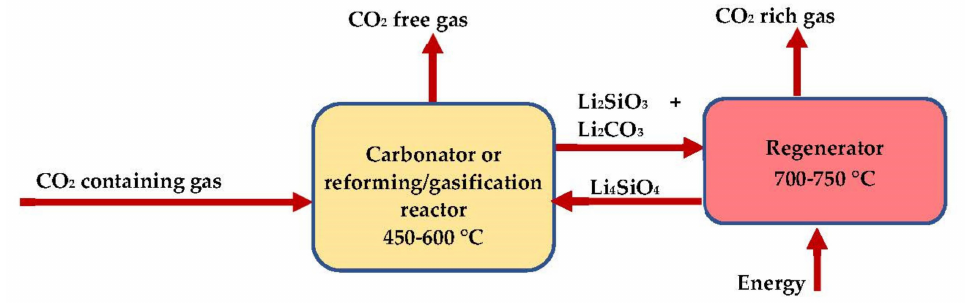
Figure 10. Carbonation–regeneration cycle of Li 4 SiO 4 sorbent.